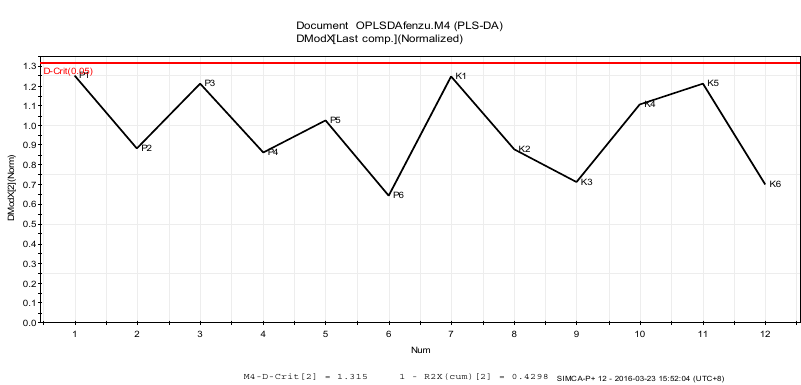
Figure 4. Distance to model X line Plot prediction in samples. ( A ) LPS and control groups; ( B ) SPPM60-D and control groups.